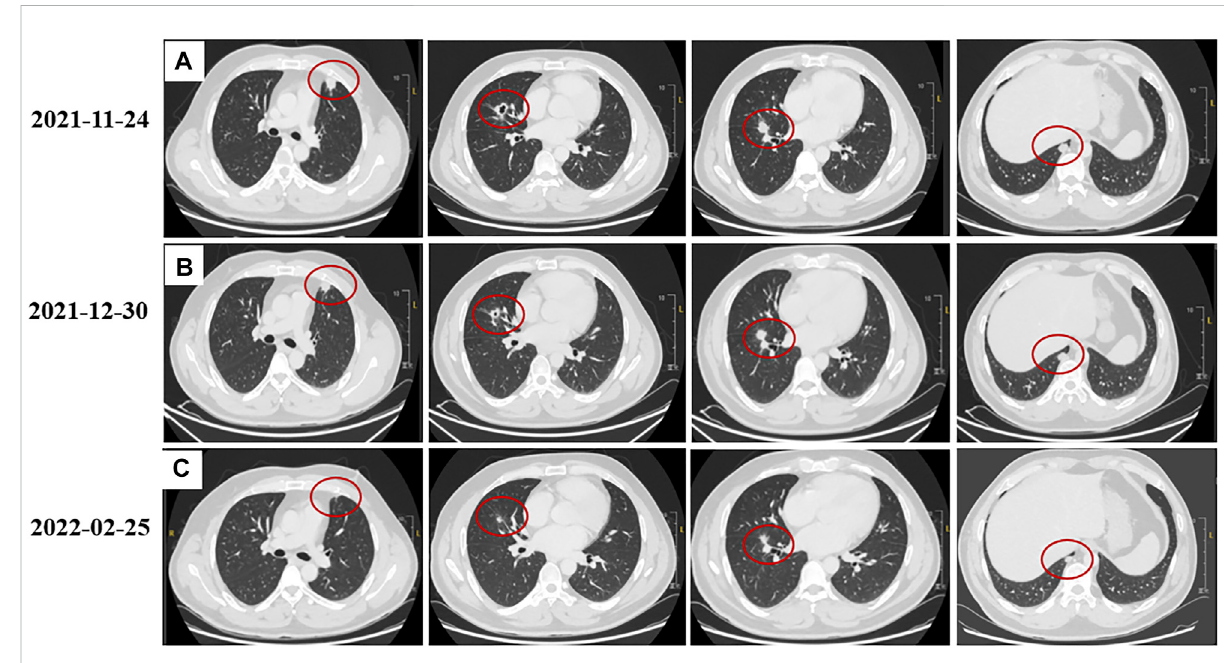
FIGURE 2 Tumor response to fl uzoparib. (A) :Lunglesions before using fl uzoparib. (B) :Lunglesions amonthafter using fl uzoparib. (C) :Lunglesionsthree months after using fl uzoparib. The red circles represent the target lesion.